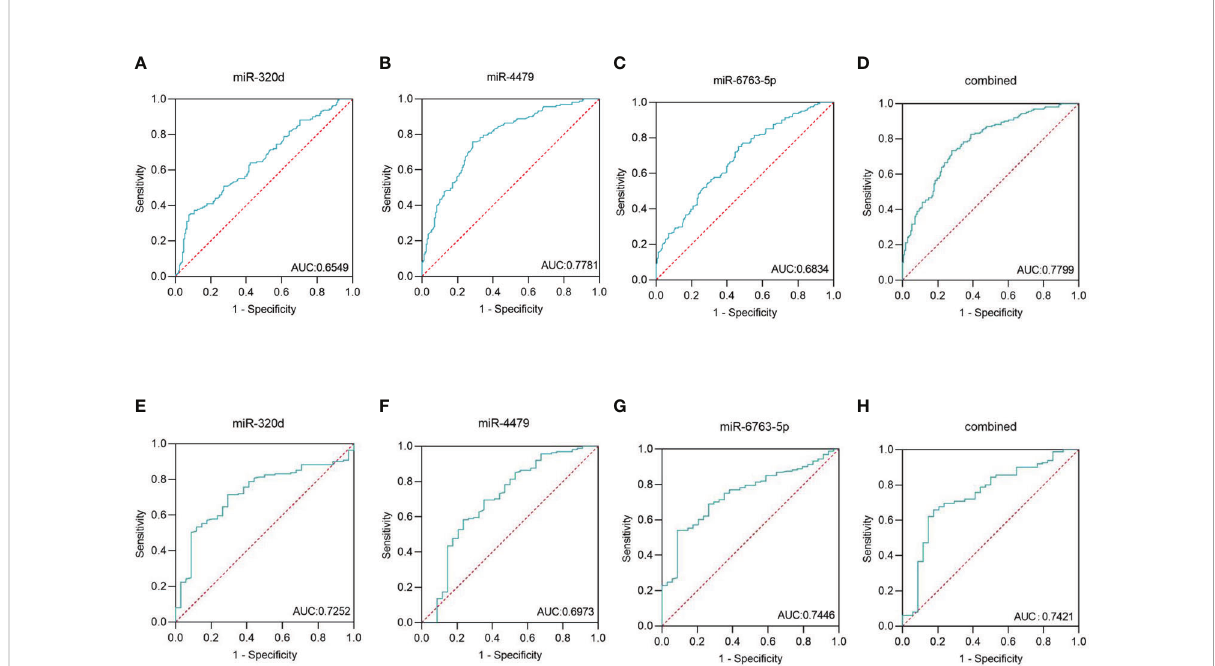
FIGURE 5 Diagnostic role of plasma exosomal miRNAs expression levels in EOC patients. The AUCs of miR-320d (A) , miR-4479 (B) , miR-6763-5p (C) , and both (D) in EOC patients relative to healthy donors. The AUCs of miR-320d (E) , miR-4479 (F) , miR-6763-5p (G) and both (H) in EOC patients relative to benign diseases patients. AUC, Areas under the curve.